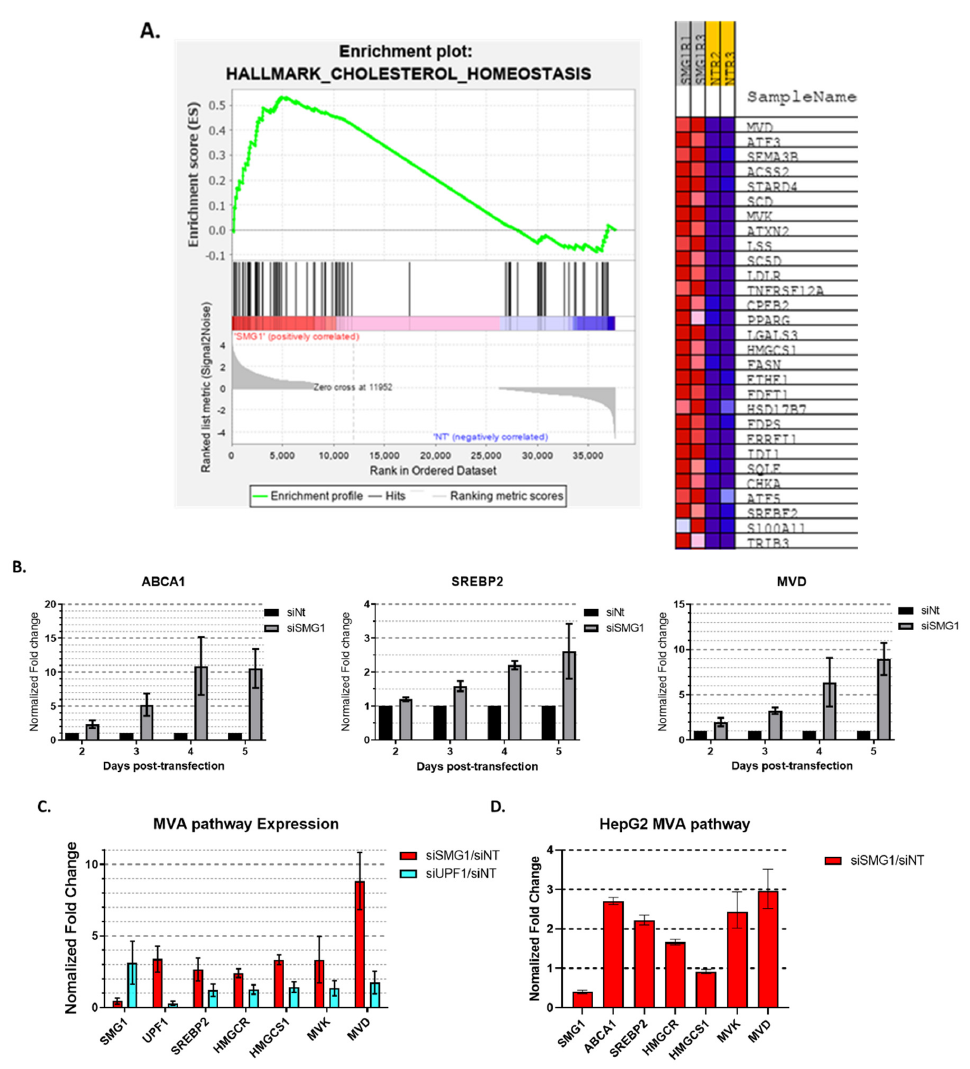
Figure 1. SMG1, but not NMD pathway, represses cholesterol metabolism. ( A ) Summary results of an exploratory gene set enrichment analysis from RNA-Seq data from RNA collected from MCF7